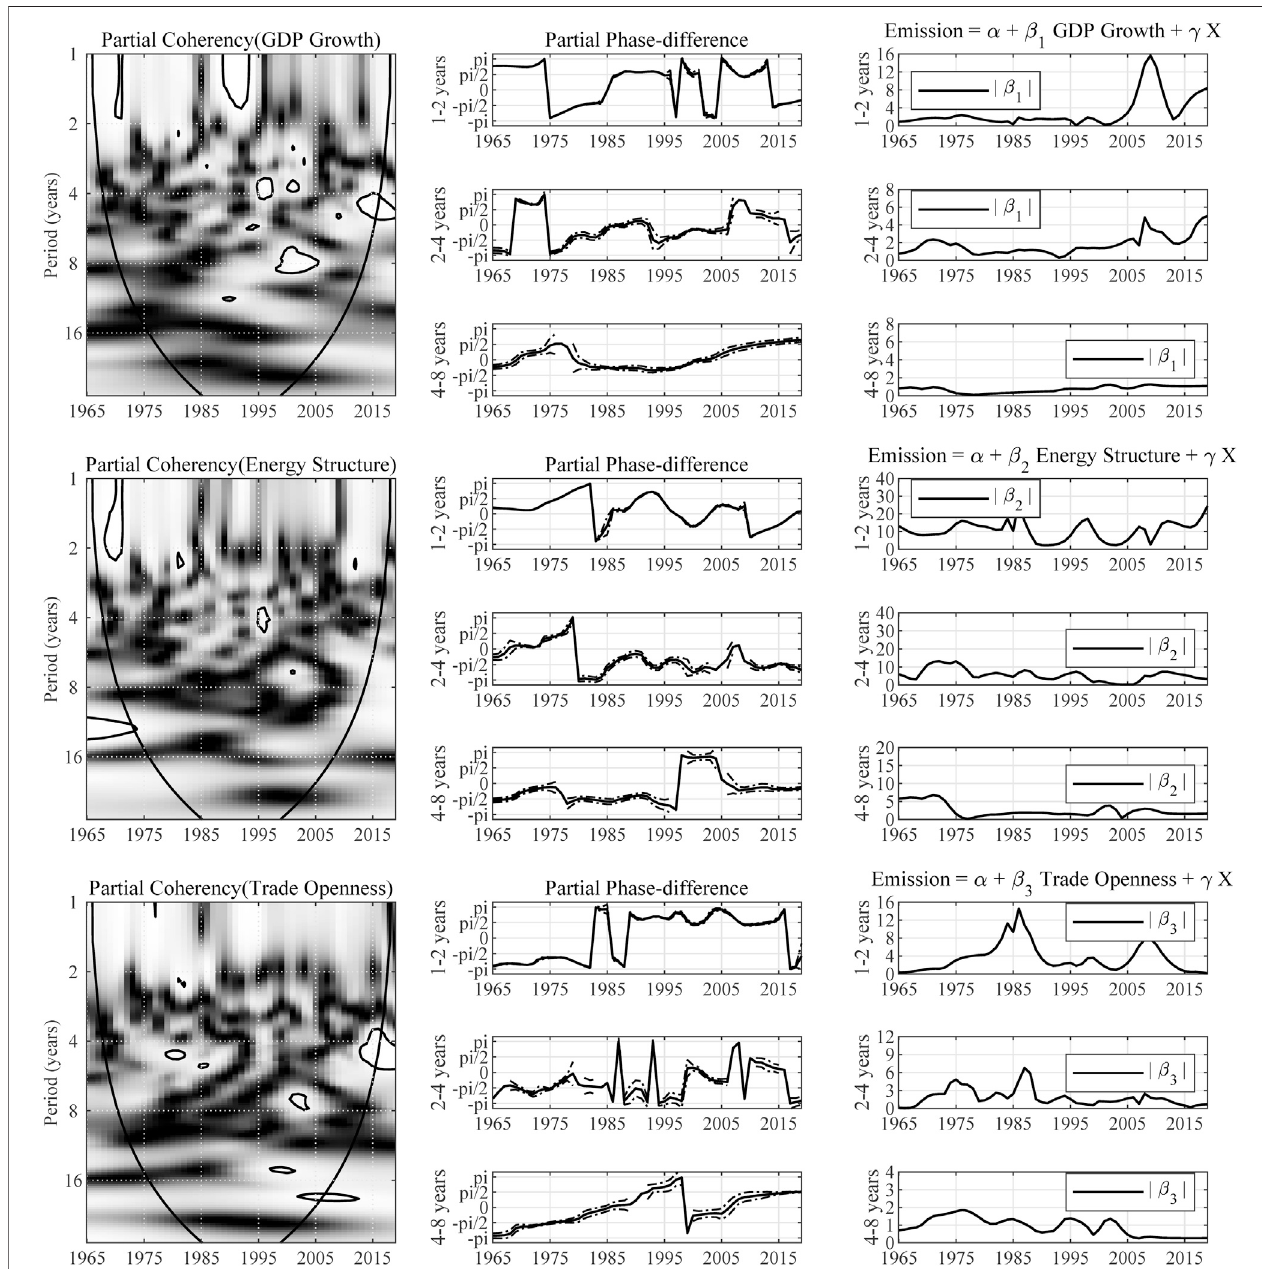
FIGURE 8 | Multivariate wavelet analysis results for India. Note: The expression “ Partial Coherency (Z) ” denotes the partial coherency between variable Z and carbon emission,controlledforthein fl uencefromotherfactors.Theareas belowthesymmetricblackconvexcurvethatappearsinthe fi gureofcoherencyarecalledthe “ Cone of In fl uence (COI), ” in which the edge effects are profound. Inside the COI, the results tend to be unreliable. The contours in the coherency diagrams indicate 5% signi fi cance level, bootstrapped for 10,000 replications. And, the brighter colors correspond to higher signi fi cance level, and darker colors correspond to lower signi fi cance level. The dotted lines accompanying the partial phase-difference indicate the 95% con fi dence intervals.